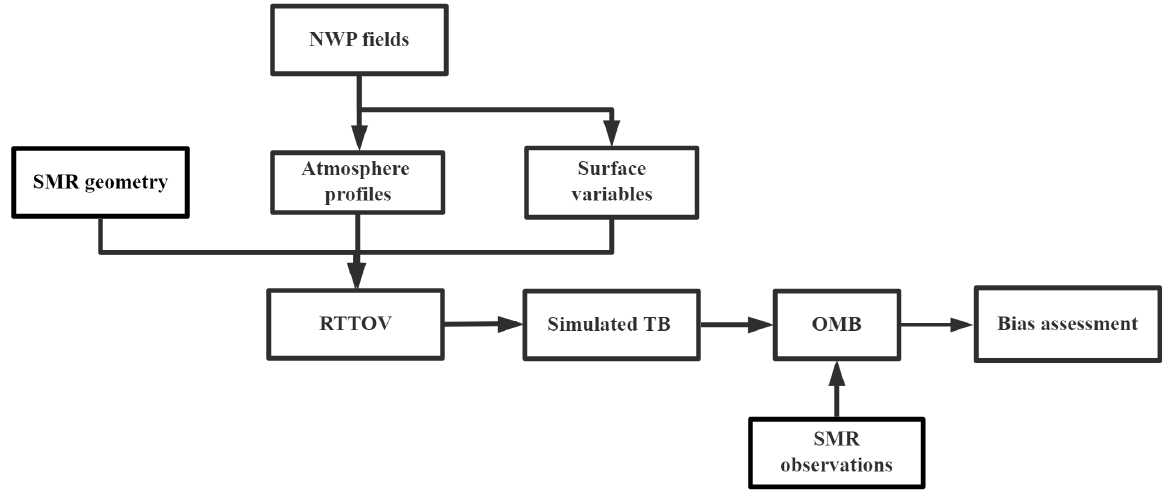
Figure 6. The flowchart for the coupling of the NWP fields and the RTTOV model used to simulate the HY-2B SMR observations for bias assessment.